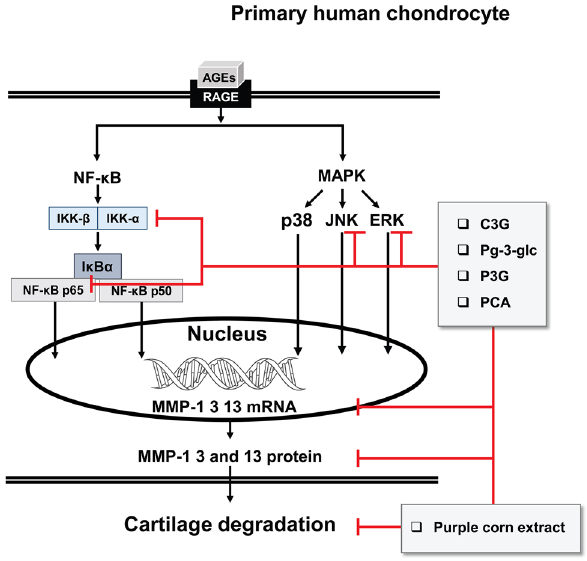
Figure 6. Inhibitory effects of purple corn anthocyanins and purple corn extract on advanced glycation end products induced inflammation in chondrocytes. C3G, cyaniding-3-O-glucoside; Pg-3-glc, pelargonidin-3-O- glucoside; P3G, peonidin-3-O-glucoside; PCA, protocatechuic